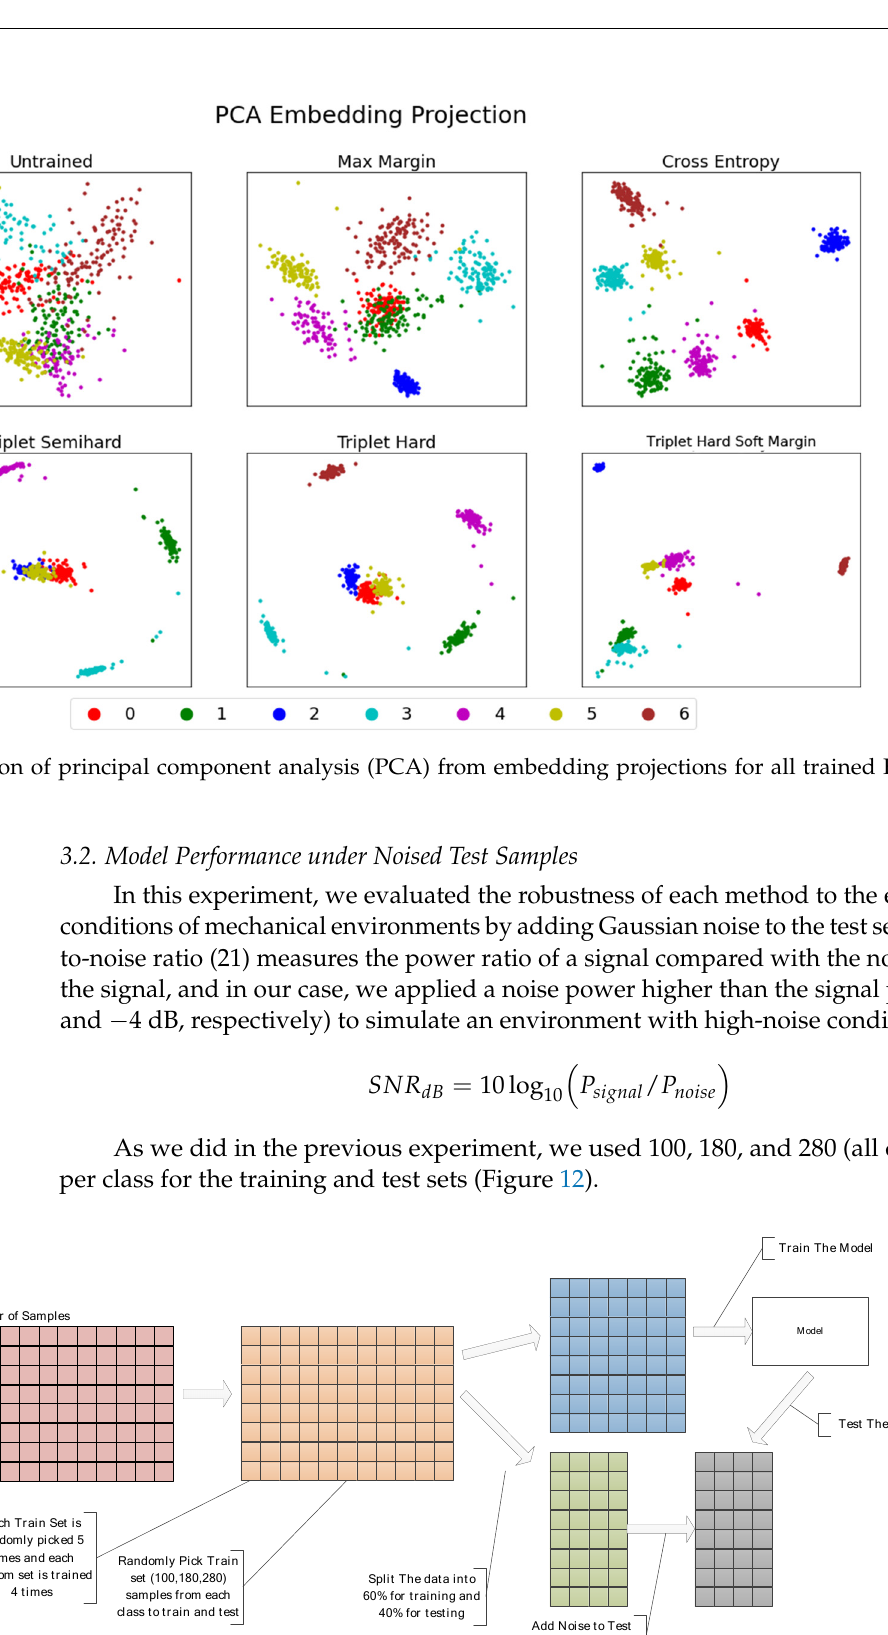
Figure 12. Performance evaluation based on various numbers of training samples and added noise on test data.